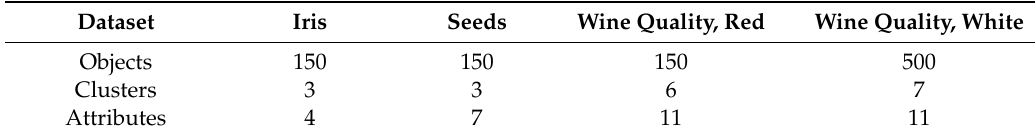
Table 1. University of California Irvine (UCI) datasets information.